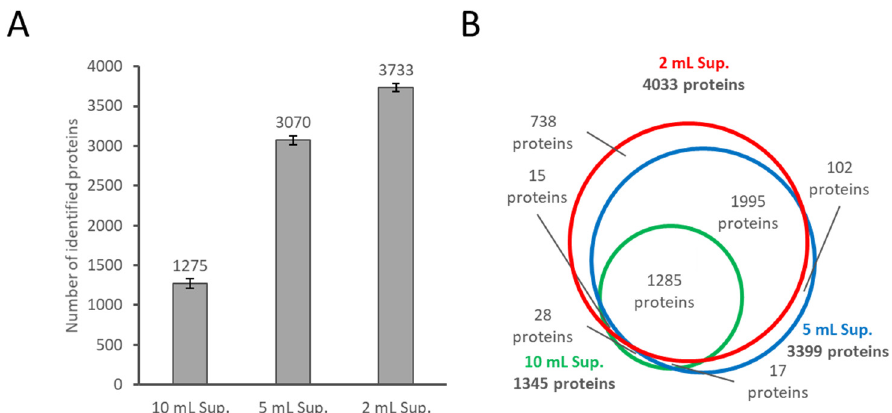
Figure 3. Effect of the volume of the medium used on proteome analysis. ( A ) Bar graph of the number of human proteins observed in albumin-depleted supernatant of cultured in 10, 5, and 2 mL of medium containing 10% FBS. ( B ) Venn diagram of the number of human proteins observed in the three treated samples. For ( A ), the results of the MS data individually analyzed by the Scaffold DIA software were used. For ( B ), the results of the simultaneously analyzed MS data collected for each treatment by the Scaffold DIA were used. Abbreviations: ALB, serum albumin; Sup, supernatant.